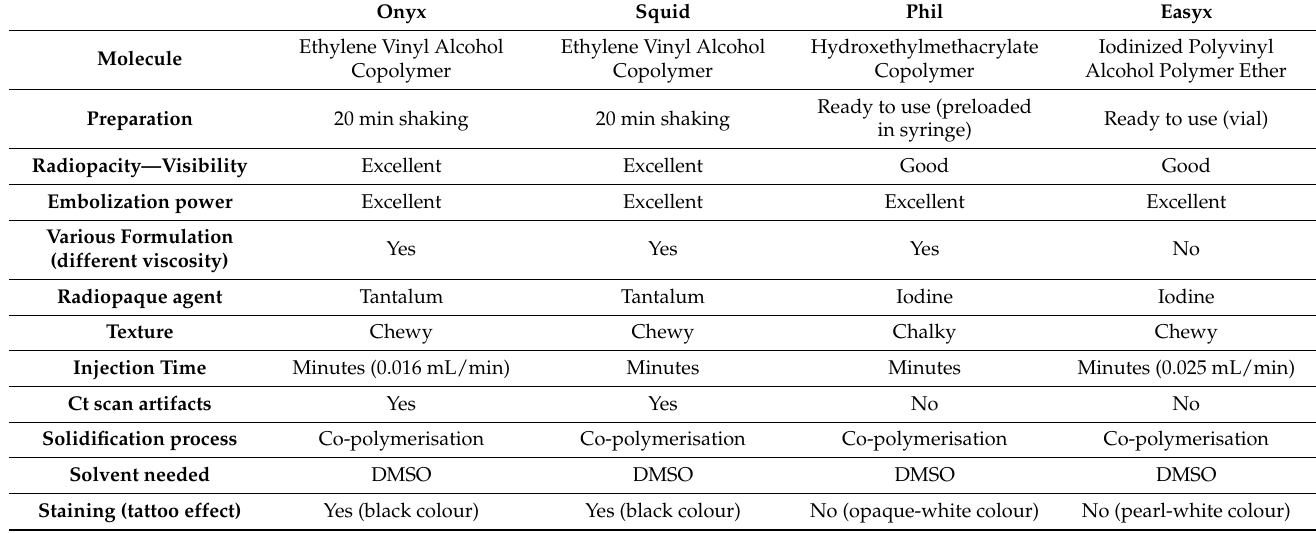
Table 1. Nalea embolic agents’